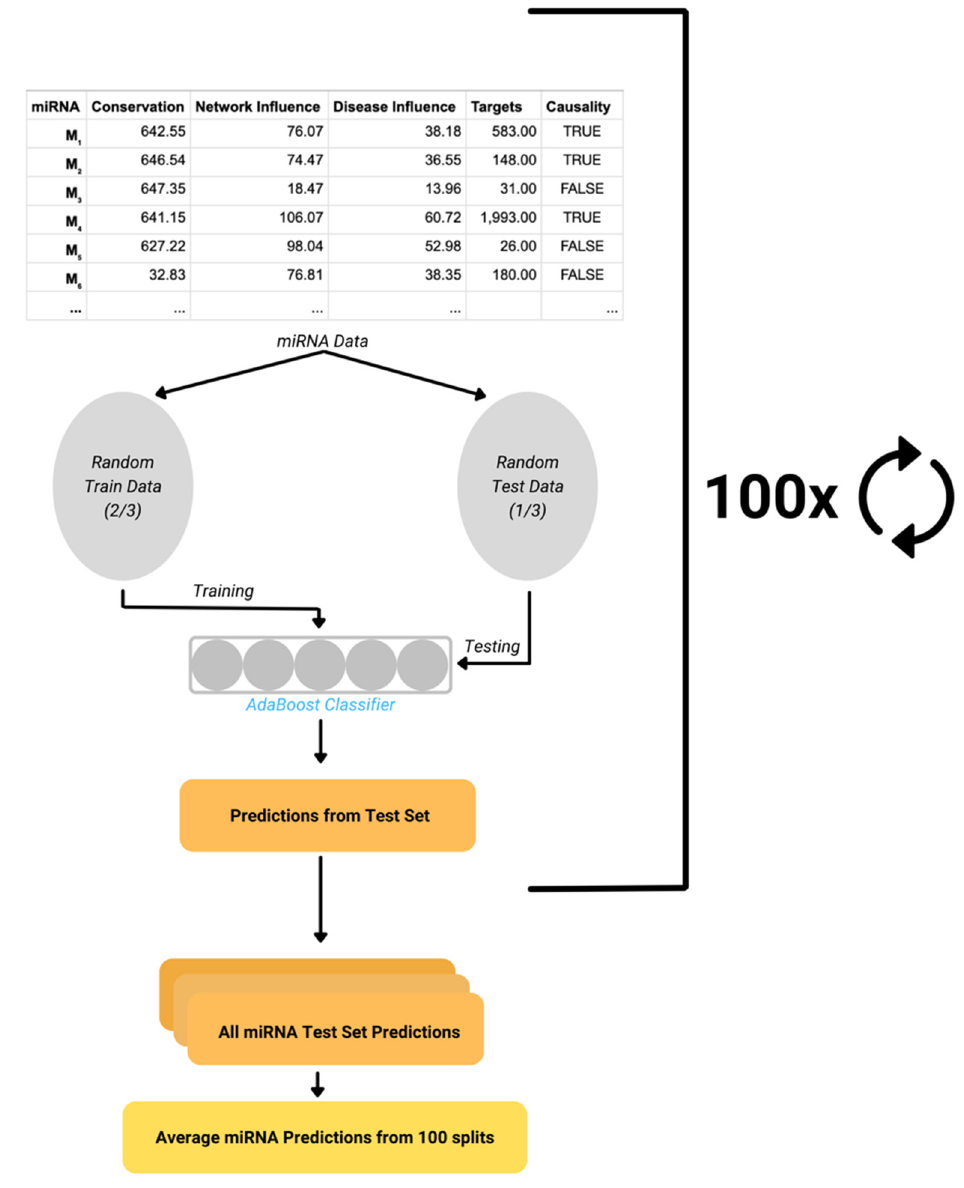
Figure 4. DisiMiR is run 100 times with different, random training and testing data splits. The predictions for each miRNA are averaged over 100 splits.